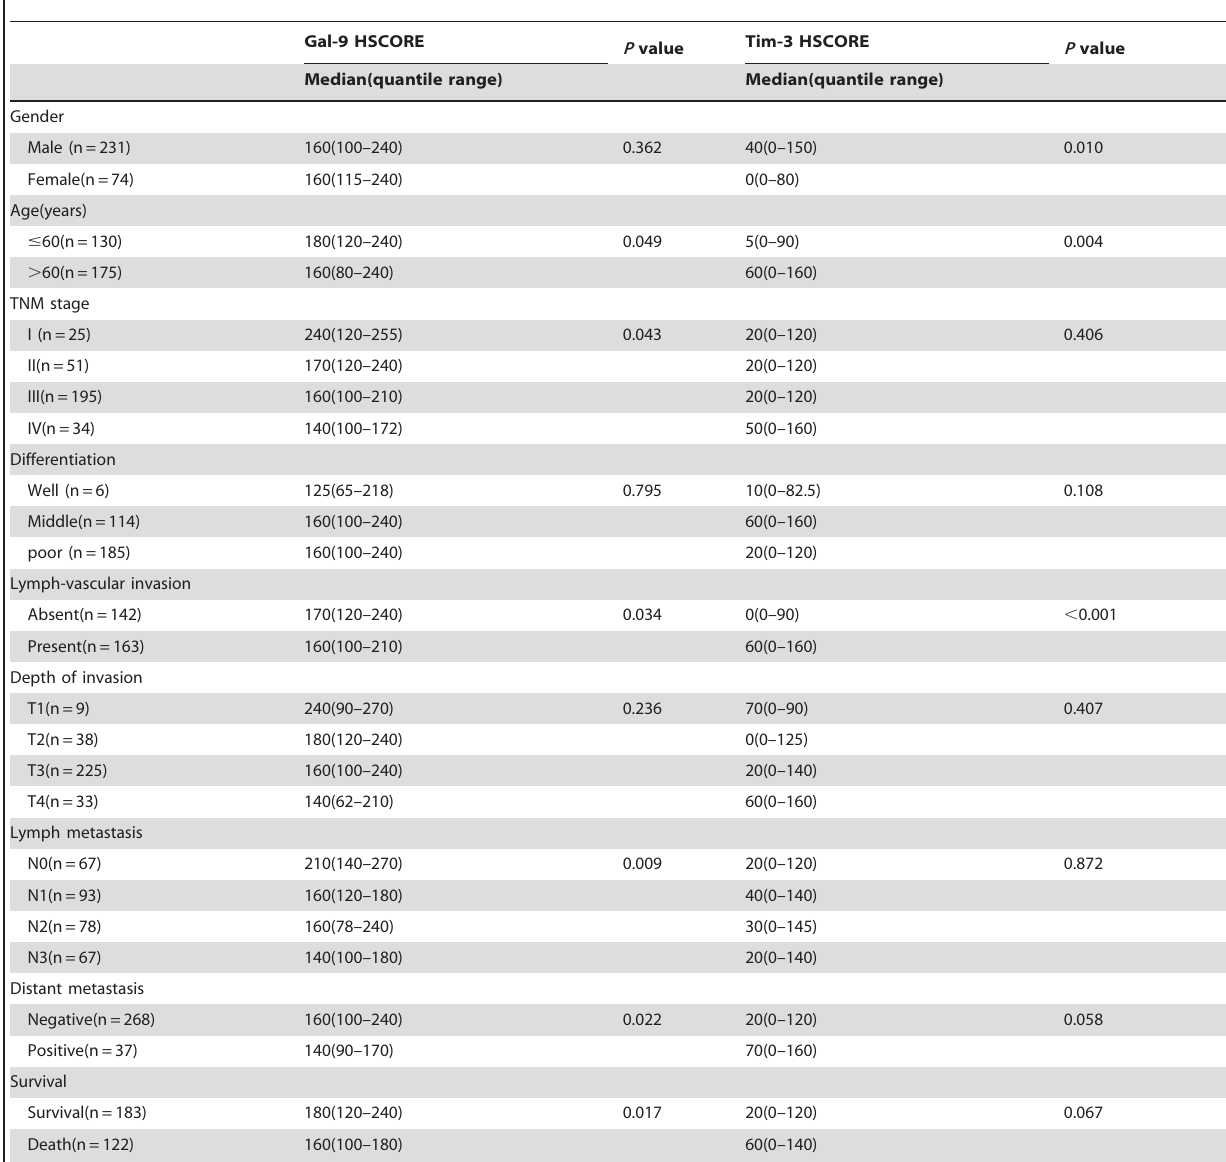
Table 1. Galectin-9 and Tim-3 expressions in gastric cancer according to clinicopathologic